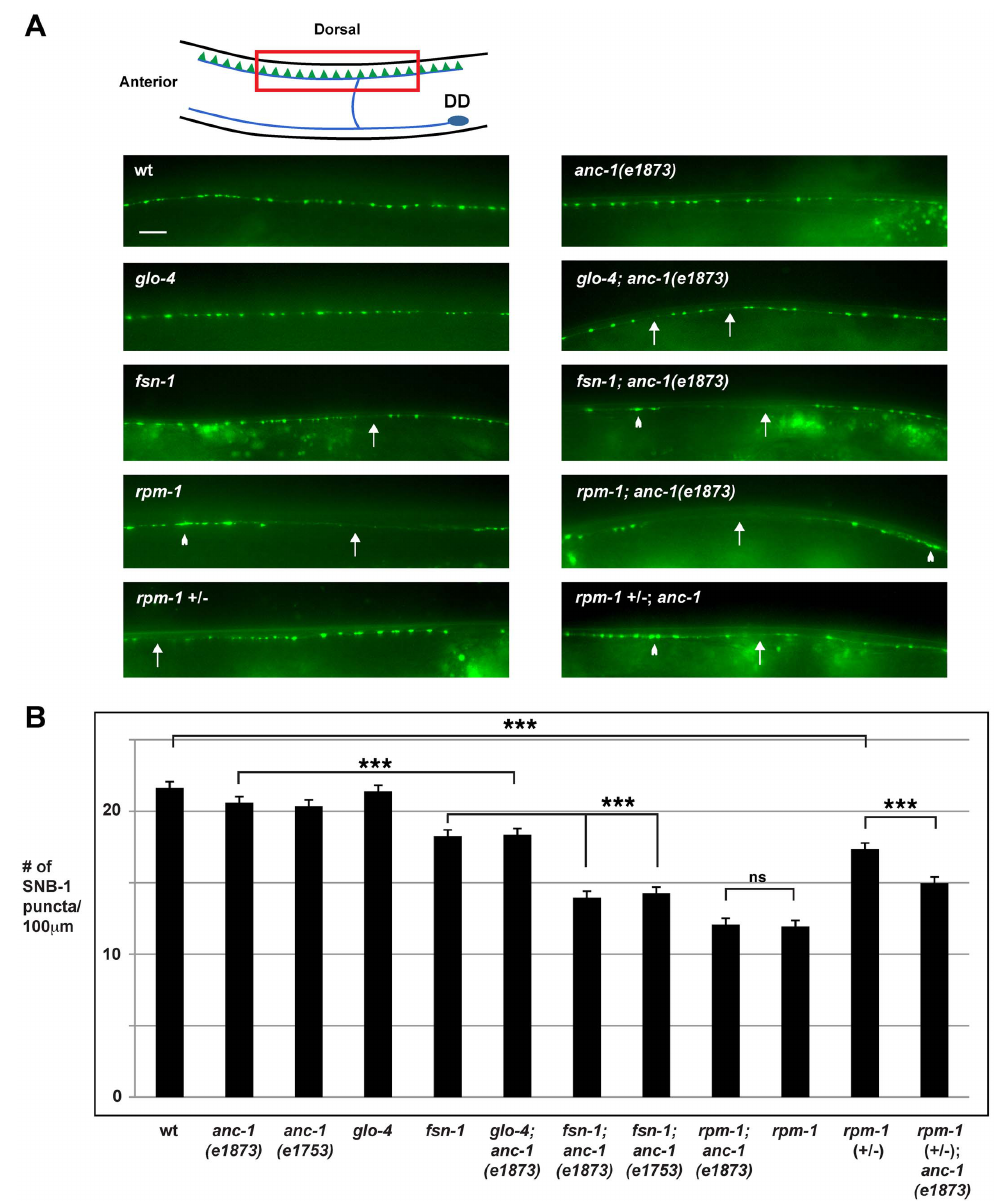
Figure 2. anc-1 regulates synapse formation in the GABAergic motor neurons. (A) Upper panel diagrams the GABAergic DD neurons (blue) that innervate dorsal muscles (inspired by Worm Atlas). DD Presynaptic terminals are shown in green. The red box highlights the region of the dorsal cord that was visualized by epifluorescent microscopy. The transgene juIs1 [P unc-25 SNB-1::GFP] was used to visualize the presynaptic terminals for the indicated genotypes. Arrows highlight regions lacking presynaptic terminals represented by SNB-1::GFP puncta. Arrowheads note abnormal aggregation of presynaptic terminals. Scale bar is 10 m m. (B) Quantitation of the average number of SNB-1::GFP puncta per 100 m m of dorsal cord for the indicated genotypes. Analysis was done on young adults grown at 25 u C. Significance was determined using an unpaired Student’s t test; error bars represent the standard error of the mean. *** P , 0.001, ns=not significant.